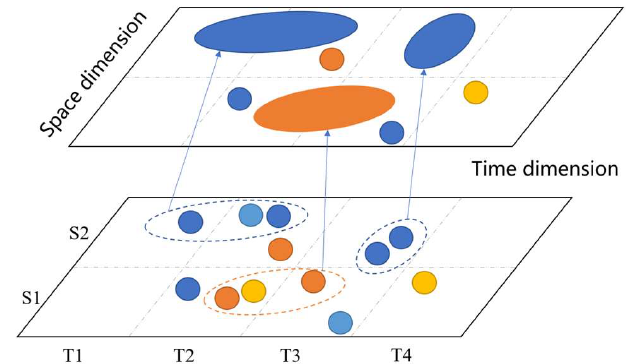
Figure 9. Schematic diagram of status unit aggregation rules.